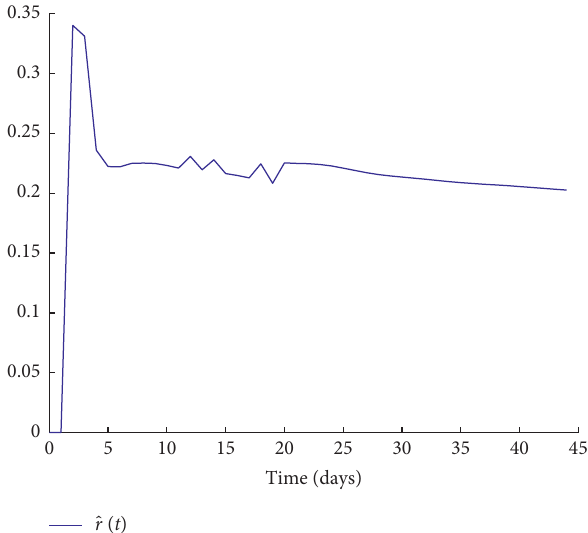
Figure 20: Estimation of β from reported filtered data (Italy) and lsqcurvefit Matlab